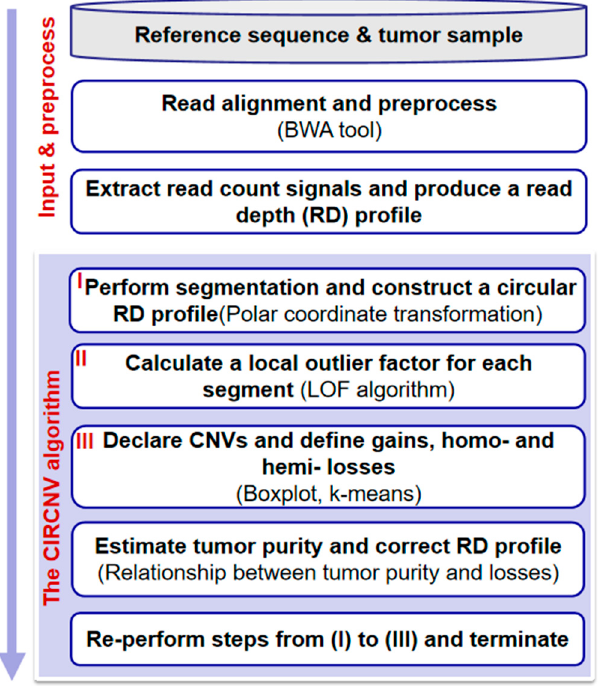
Figure 1. Flowchart of the CIRCNV method. It is composed of two parts: input and preprocessing, and the algorithm of CIRCNV.